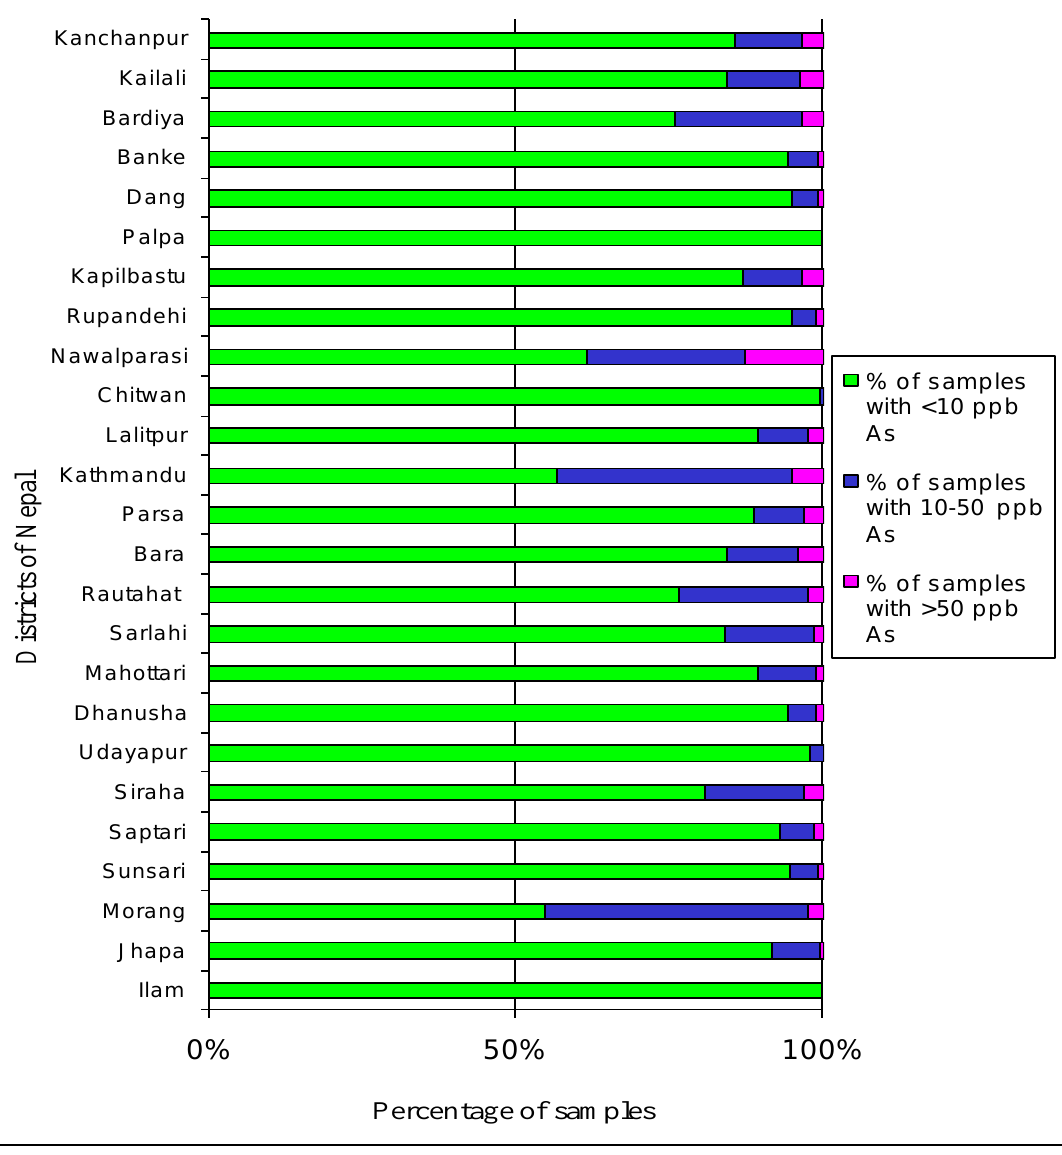
Figure 6. Overall arsenic concentration in the groundwater of